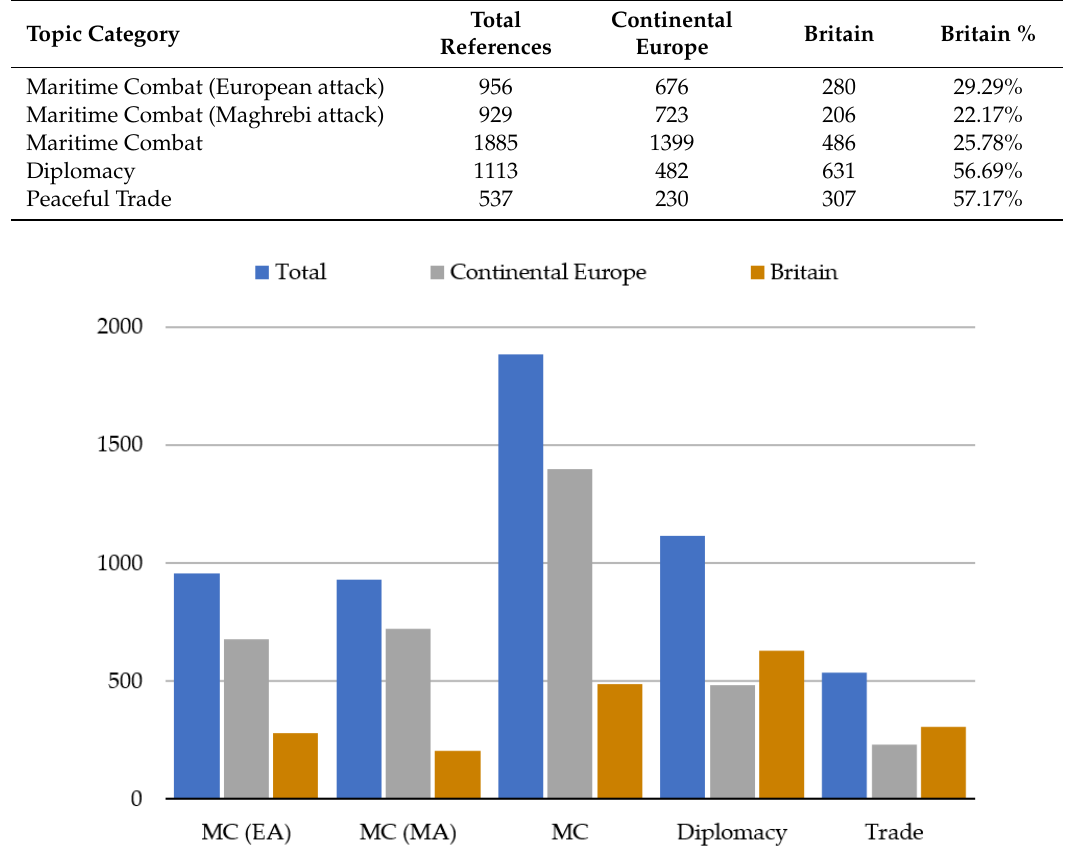
Figure 2. References to maritime combat, diplomacy and trade (British and European relations). Table 3. Classifications for Maghrebi ships at sea (number of articles employing term, highlighting most common category in each period).